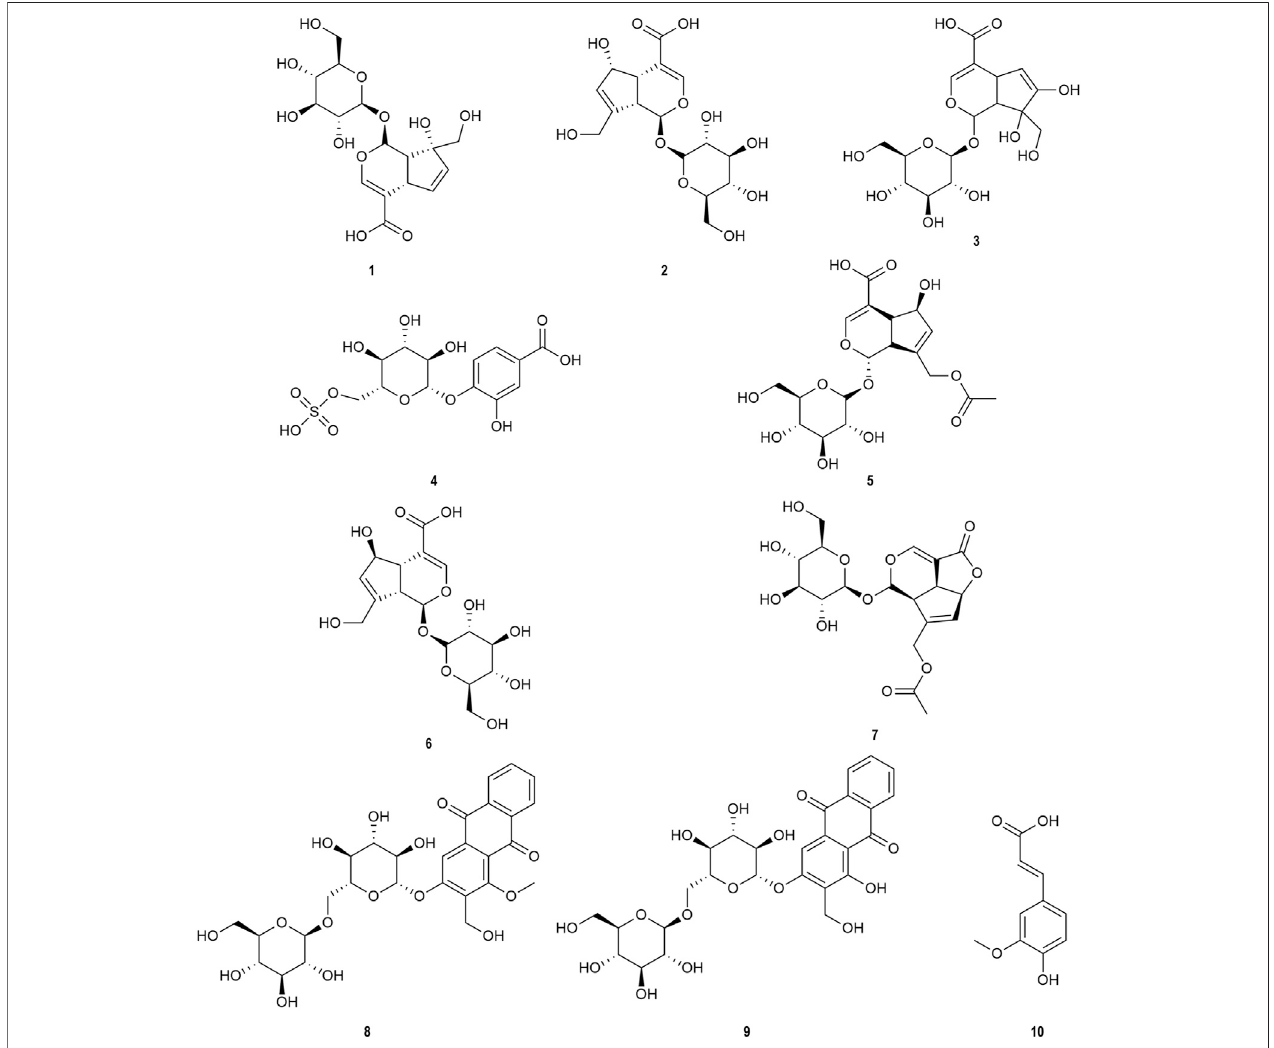
FIGURE 3 | Chemical structures identi fi ed in OH. 1) Monotropein. 2) Deacetylasperulosidic acid. 3) 6,7-dihydroxy-7-(hydroxymethyl)-1-(((2S,3R,4S,5S,6R)-3,4,5- trihydroxy-6-(hydroxymethyl)tetrahydro-2H-pyran-2-yl)oxy)-1,4a,7,7a-tetrahydrocyclopenta [c]pyran-4-carboxylic acid. 4)